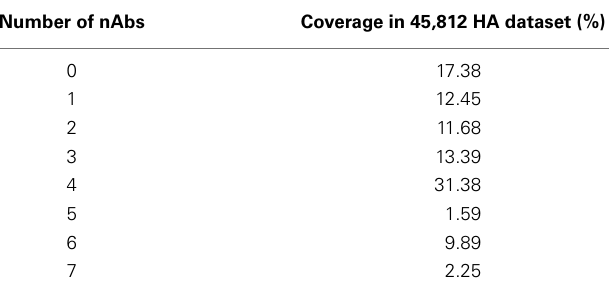
For each sequence within the 45,812 HA dataset, the number of nAbs that share identical neutralized motif was counted.The number of nAbs in our panel for any given influenza strain can range from 0 to 7.